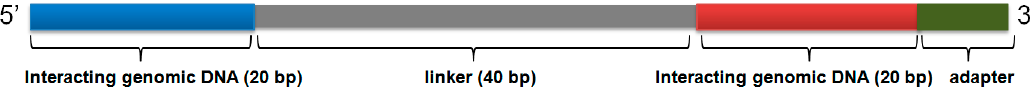
Figure 2. The composition of a DLO Hi-C DNA fragment. The DLO Hi-C DNA fragment contains two interacting genomic DNAs, 40 bp linker sequences, and adapter bases. interacting genomic DNAs, 40 bp linker sequences, and adapter